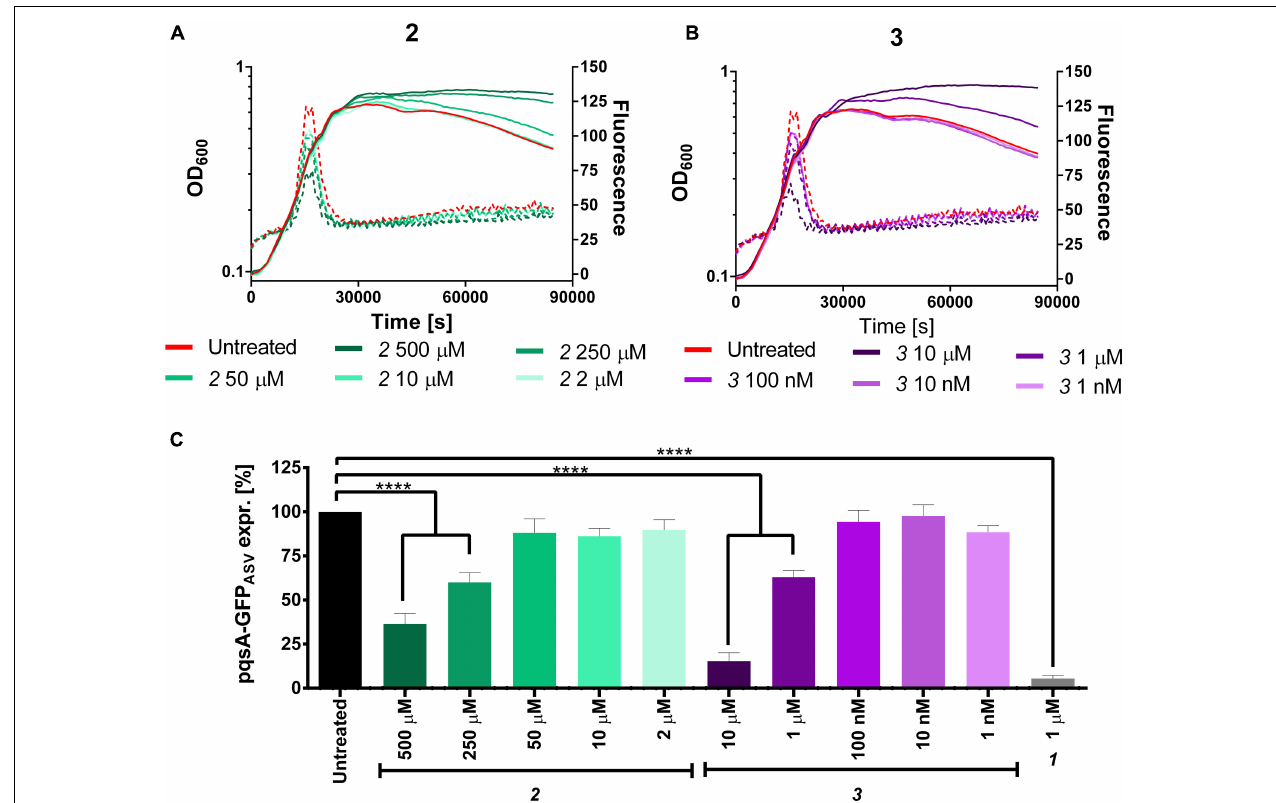
FIGURE 9 | Expression of pqsA-GFP ASV (dotted lines) and growth curves (solid lines) of Pseudomonas aeruginosa treated with 2 (A) and 3 (B) . (C) Percentage of pqsA-GFP ASV expression after PqsBC inhibitors addition. The error bars indicate Standard Error of the Mean. Statistical analysis performed with one-way ANOVA ( α = 0.05; ∗∗∗∗ p <